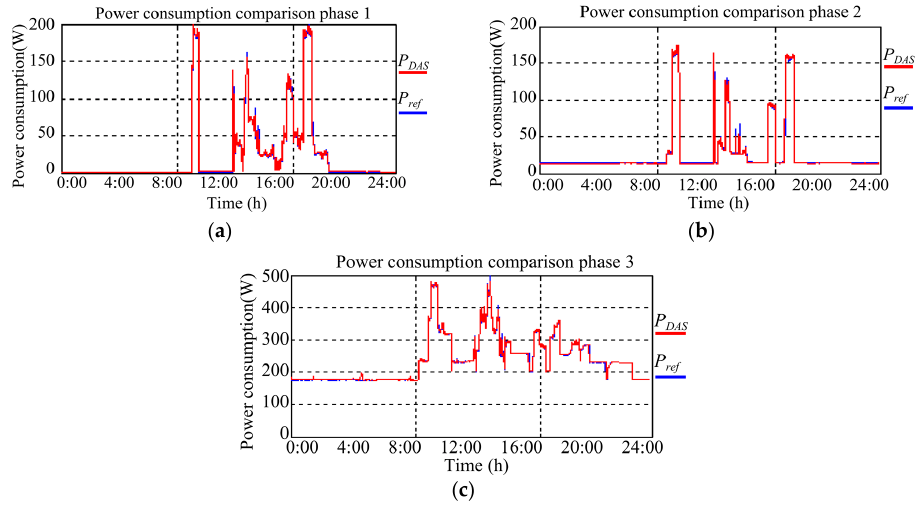
Figure 7. Validation results ( a ) phase 1; ( b ) phase 2; and ( c ) phase 3.